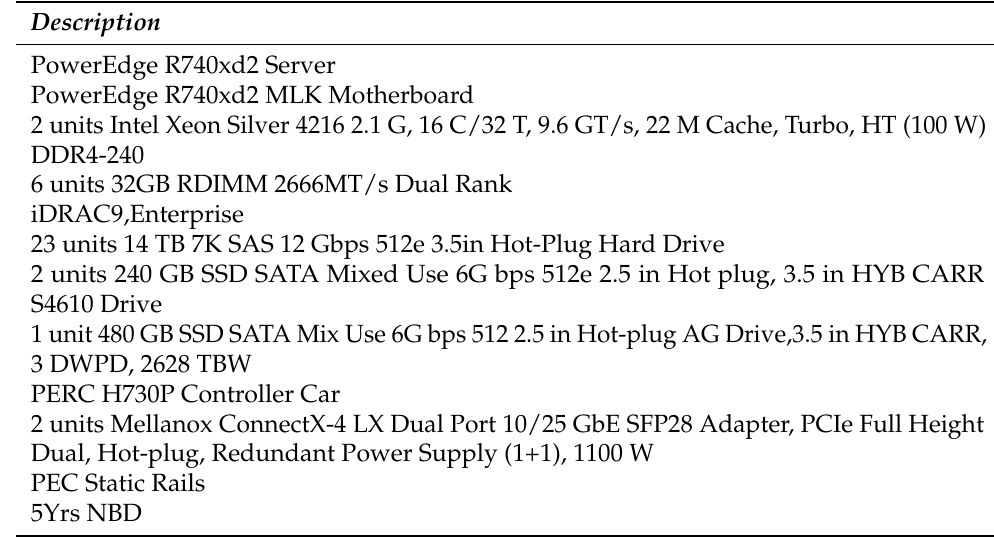
Table 4. Archive Storage